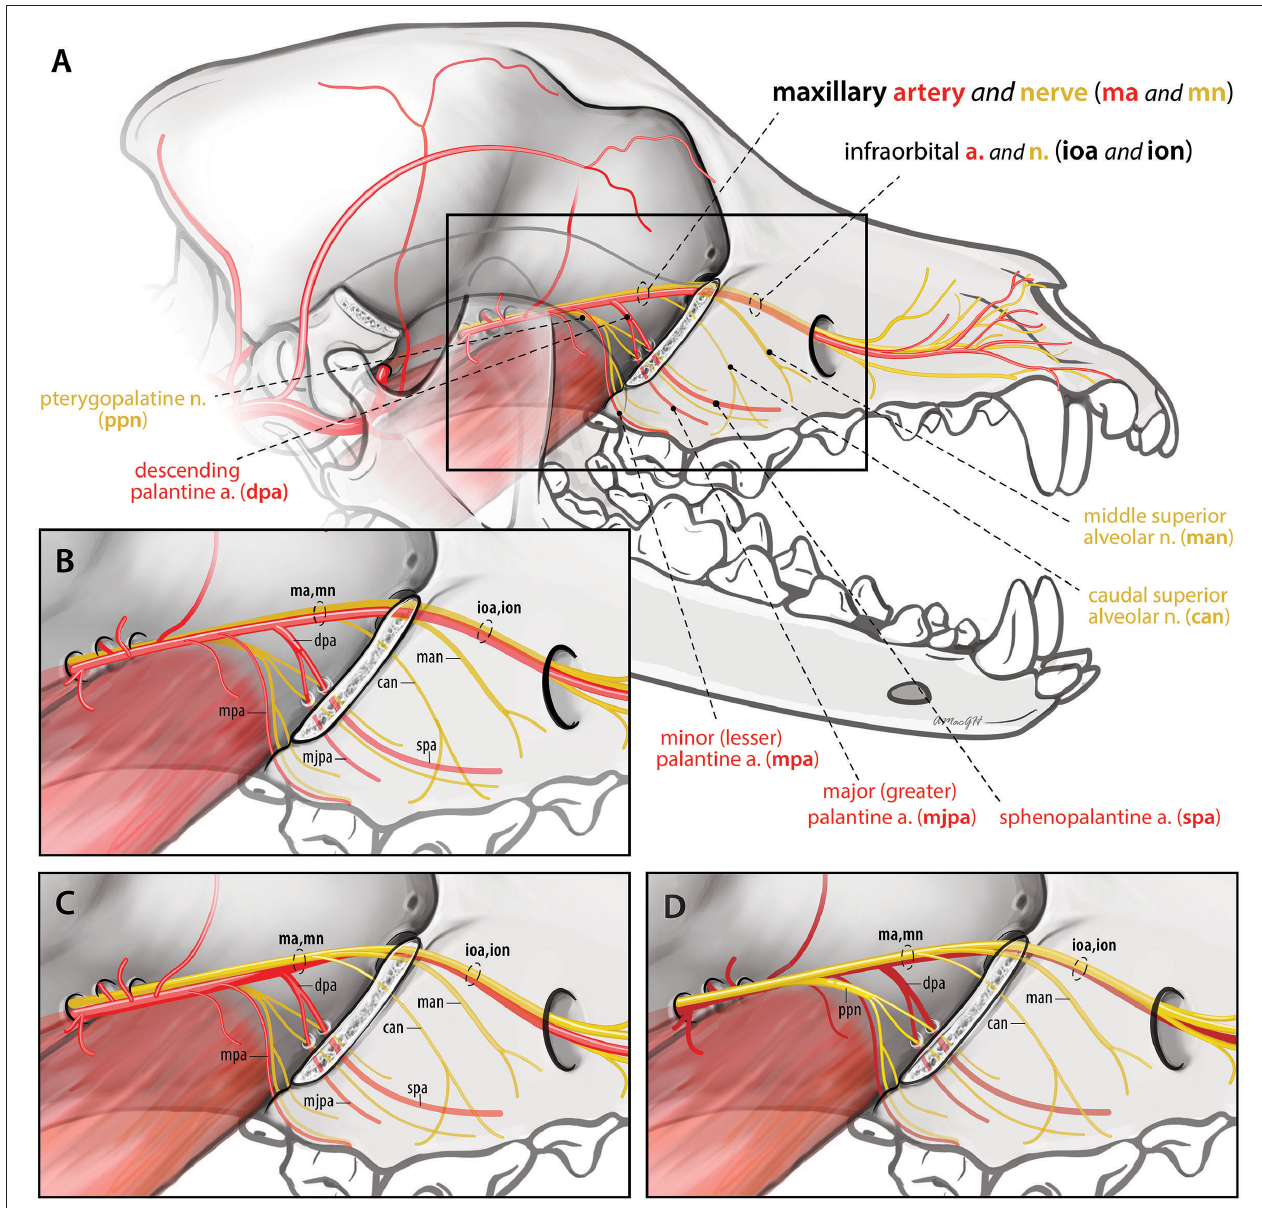
FIGURE 1 | Spatial relationship of the maxillary nerve and artery branches caudal to the infraorbital canal. (A,B) (inset) Version 1: Arterial branches remain lateral to nerve branches throughout ( n = 7). Maxillary artery (ma), minor palatine artery (mpa), descending palatine artery (dpa), infraorbital artery (ioa), major palatine artery (mjpa), sphenopalatine artery (spa), maxillary nerve (mn), caudal superior alveolar nerve (can), middle superior alveolar nerve (man), infraorbital nerve (ion). (C) Version 2: The infraorbital artery rostral to the descending palatine artery runs ventral and then medial to the nerve prior to entering the infraorbital canal ( n = 12). (D) Version 3: All arterial branches lay medial to the maxillary, caudal superior alveolar, middle superior alveolar and infraorbital nerves ( n = 1).